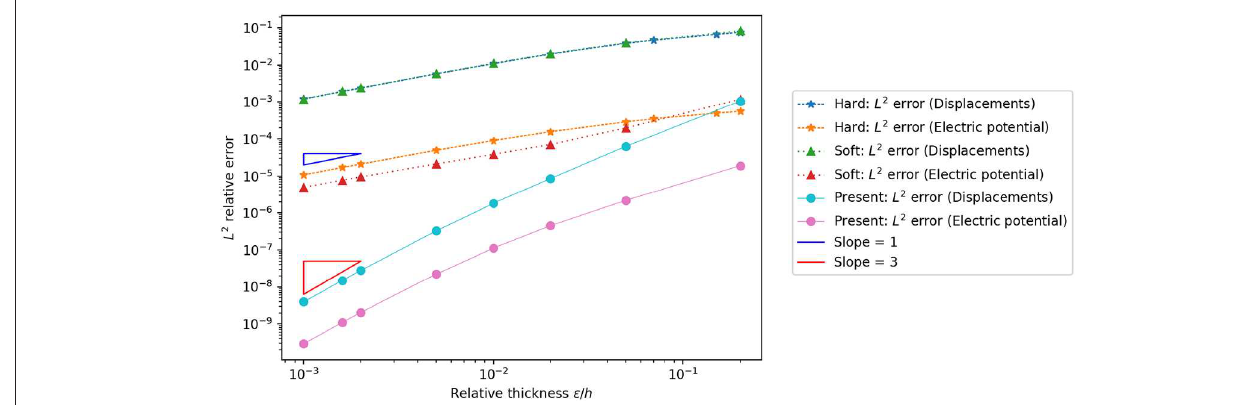
FIGURE 2 | Convergence results with respect to the relative thickness ε/ h .